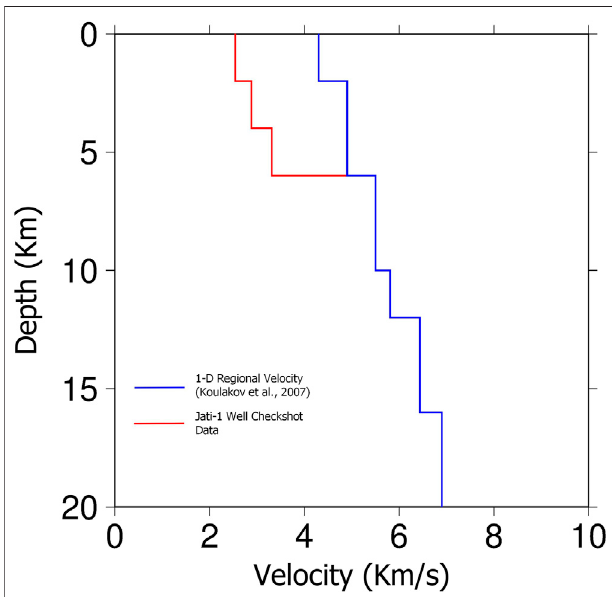
FIGURE 3 | Comparison of top 20 km regional 1-D velocity (Koulakov etal.,2007)andlocal1-DvelocityusingJati-1wellcheckshotdatatospecifya layered model or a 3-D velocity model. Jati-1 well checkshot data give a more detailed velocity contrast on the shallow crust. We used 1.74 as initial Vp/Vs ratio value for tomography inversion. The complete 1-D initial velocity model which we used in this study is shown in Supplementary Table S1 .